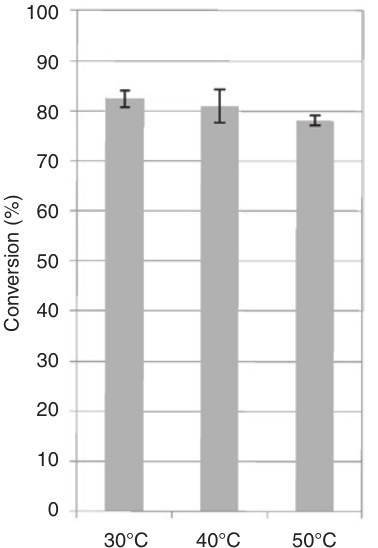
Figure 8: Conversion of benzaldehyde at 30 ° C, 40 ° C and 50 ° C in a tubular laminar reactor by applying a 0.7 M solution of tris(hydroxymethyl)aminomethane (TRIS) as a scavenger and for a 10 min reaction